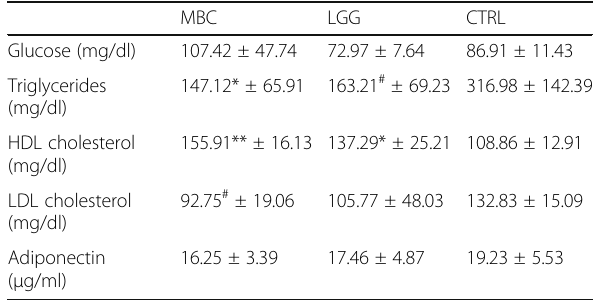
Table 1 Body weight, epididymal WAT weight, and food and energy intake from HFD of MBC, LGG, or CTRL mice